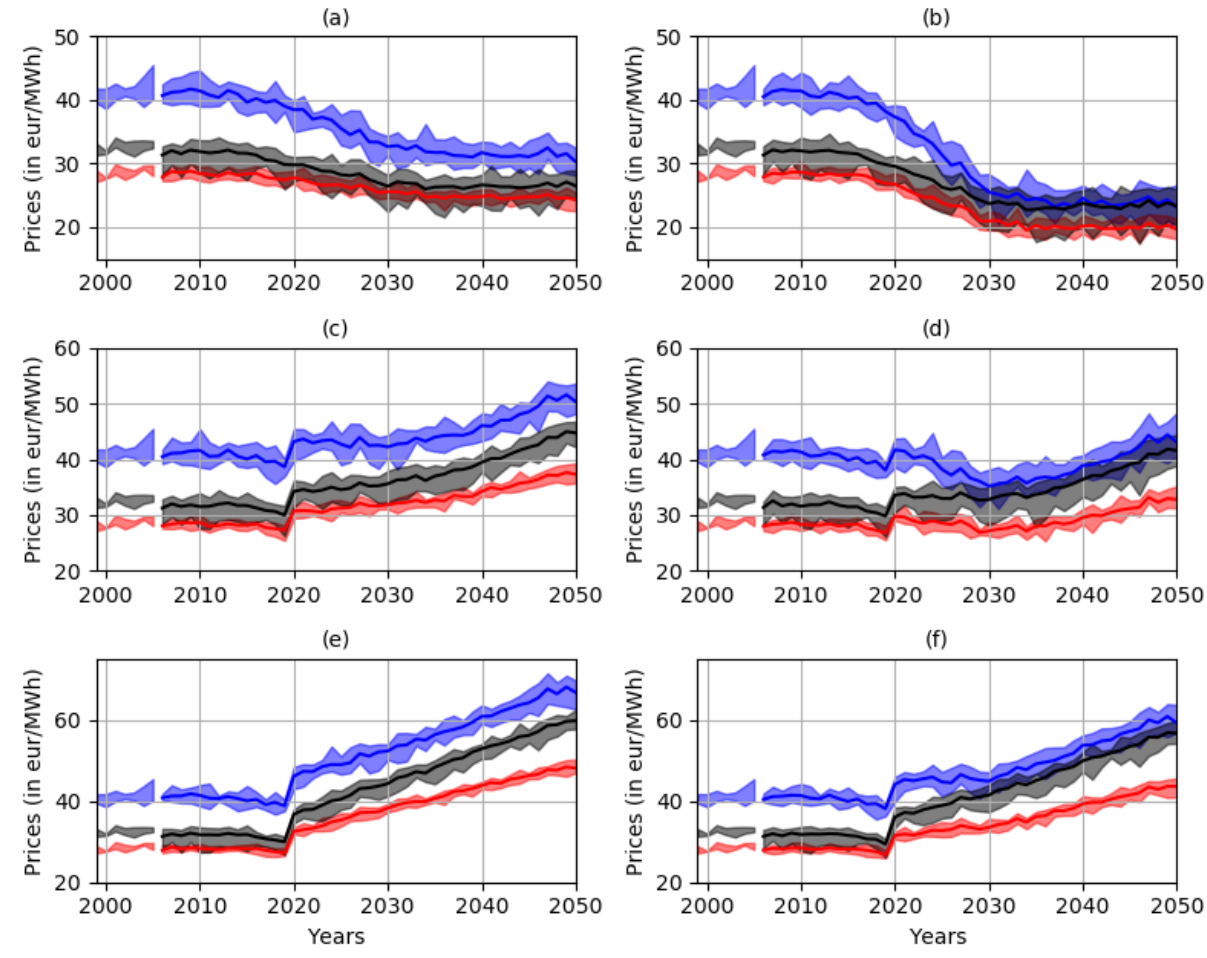
Figure 5. Yearly average price projections for each of the 6 different economic scenarios (blue for France, black for Germany, red for Denmark). Left panels correspond to low penetration scenarios ( a , c , e ) and right panels to high penetration scenarios ( b , d , f ). Top panels correspond to no demand trend scenarios ( a , b ), middle panels to medium demand trend scenarios ( c , d ), and bottom panels to high demand trend scenarios ( e , f